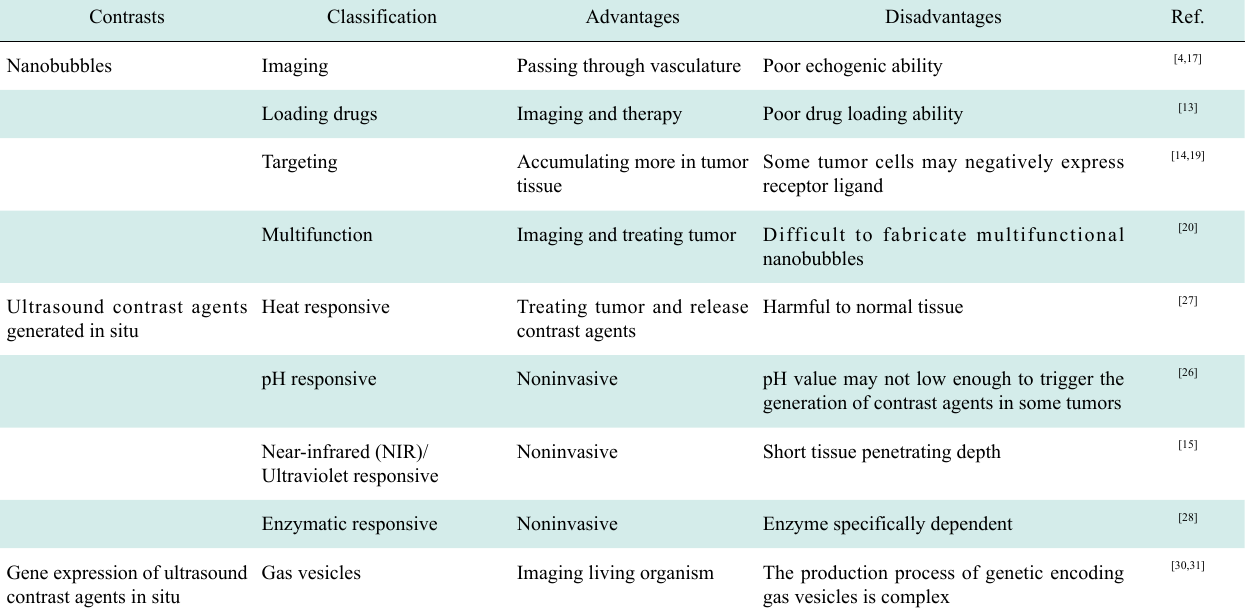
Table 1 Tumor in situ ultrasound imaging strategies Contrasts